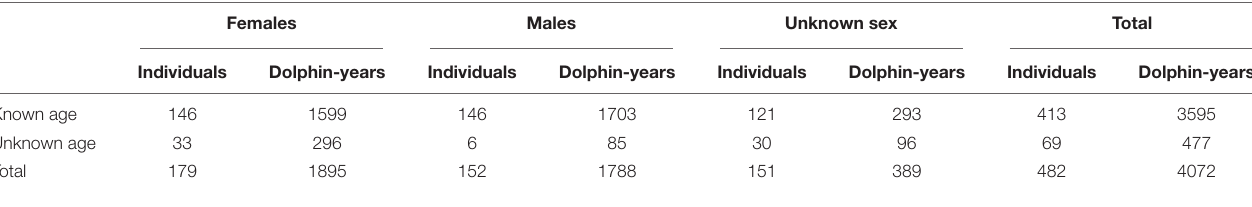
TABLE 1 | Number of individually identifiable dolphins, and dolphin-years of observation, in the Sarasota Bay resident population from 1993 through